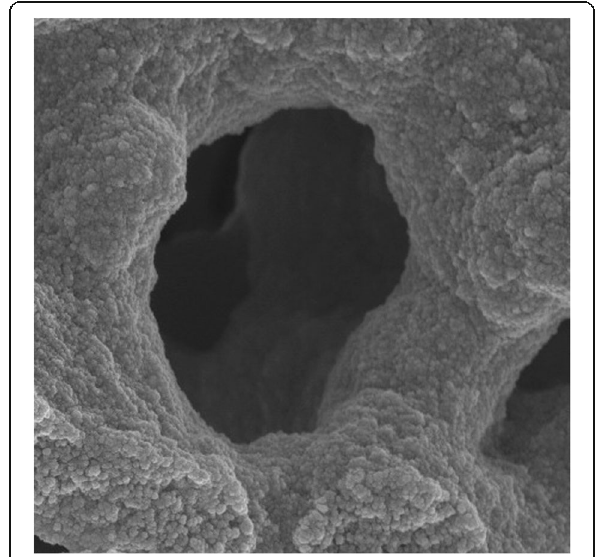
Fig. 3 Mesopore in a monolithic column (Cabrera,